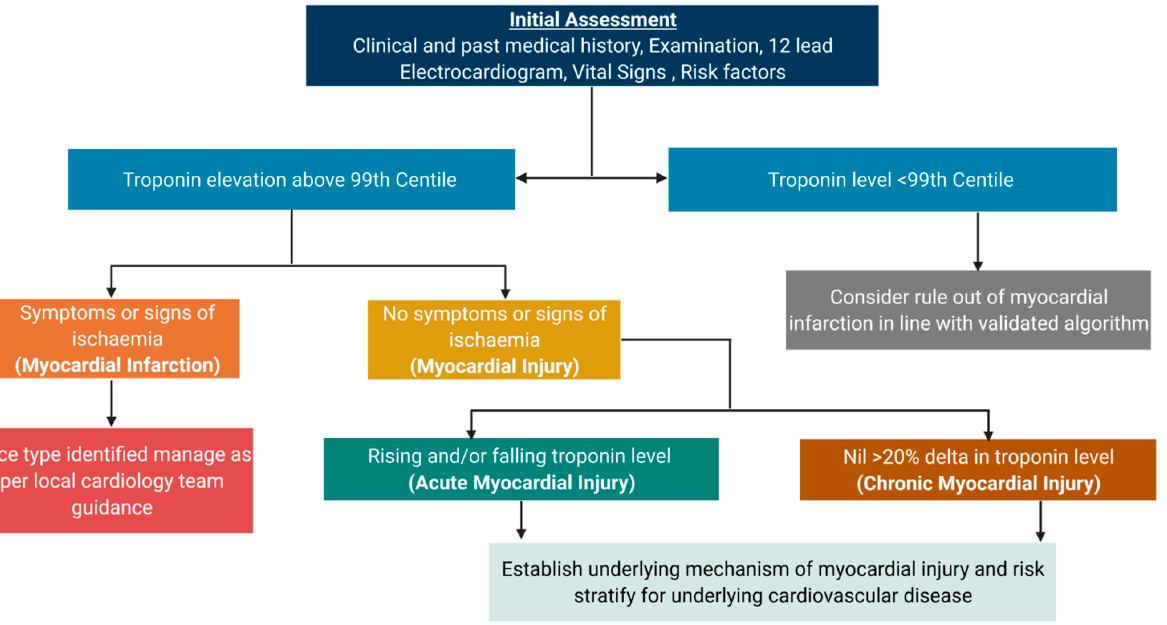
Figure 5. Taxonomy of myocardial injury and subclasses paired with basic investigation and management strategy.